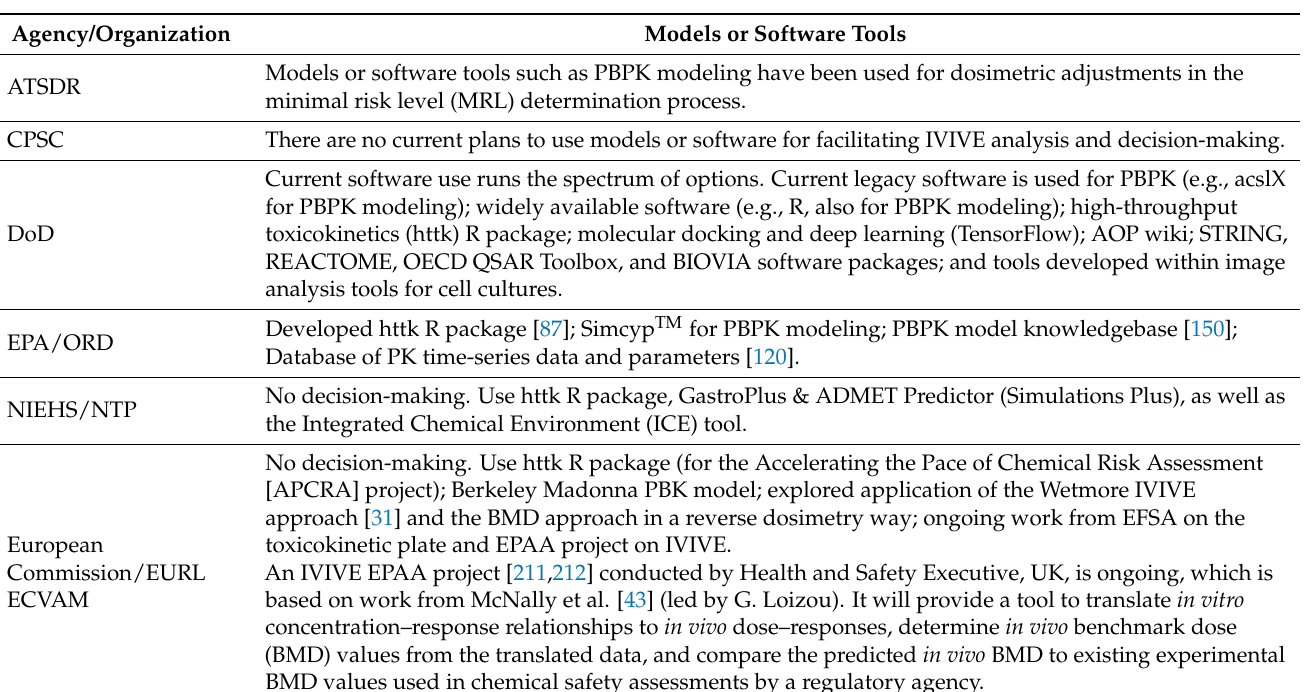
Table 3. The models or software tools agencies and organizations plan to use or make available to facilitate IVIVE analysis in decision